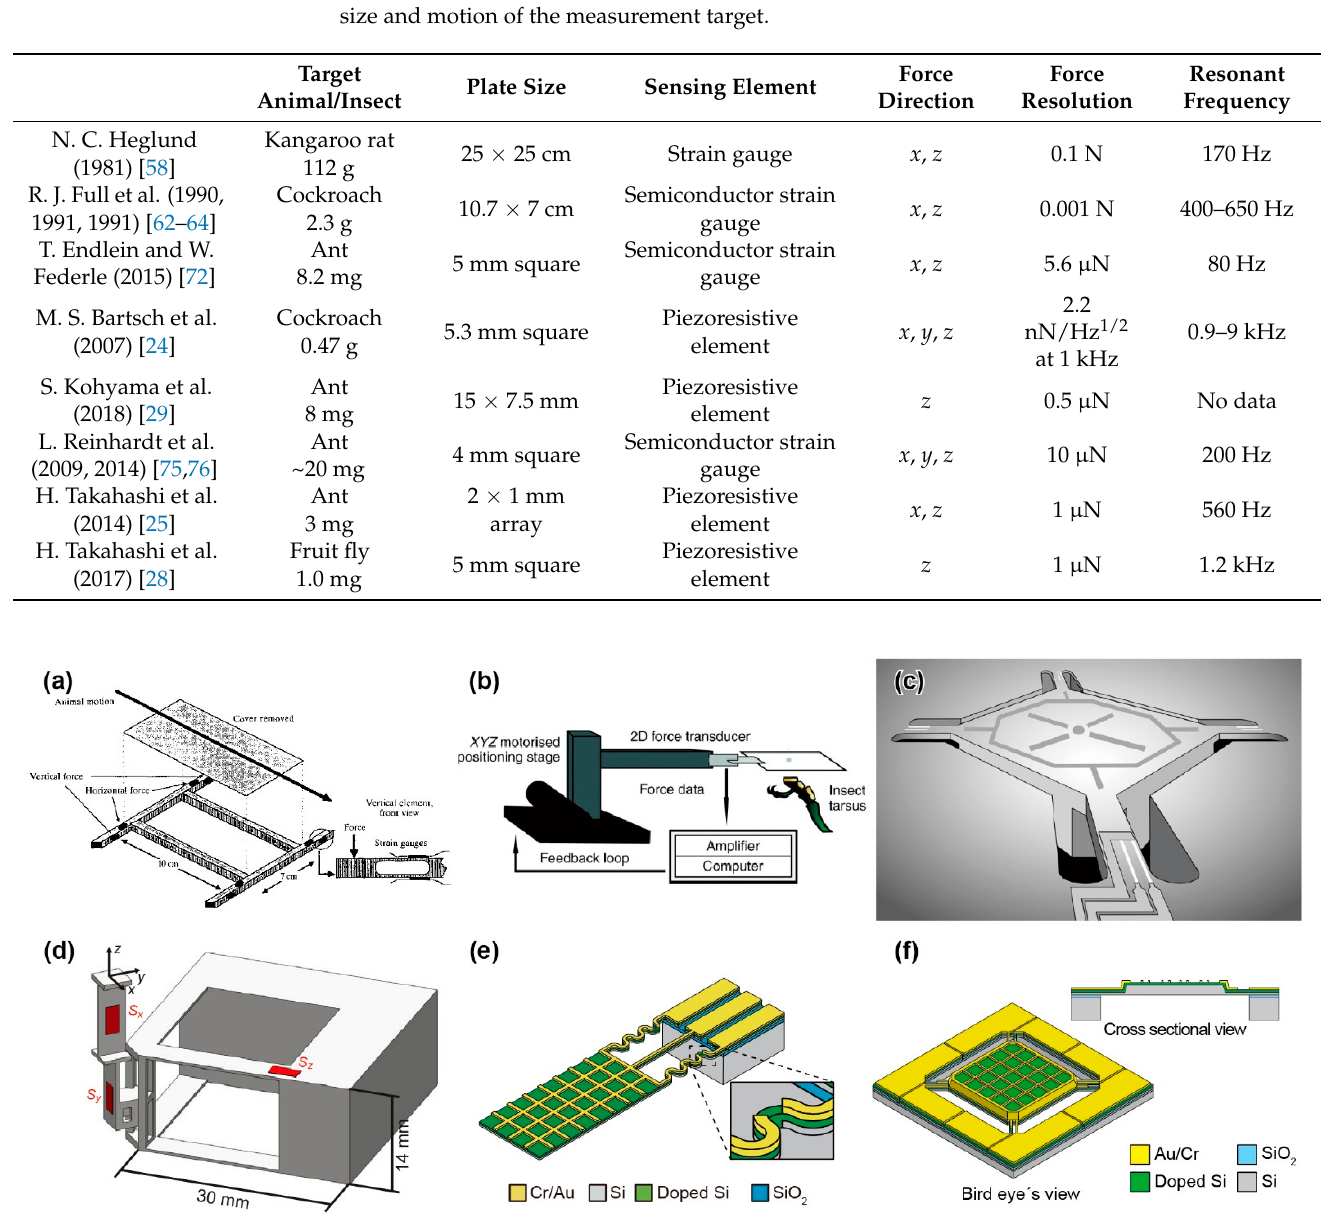
Figure 1. Schematic images of micro-force plates for insects. ( a ) Biaxial force plate for a cockroach. Reprinted/adapted with permission from Ref. [62]. 2022, Company of Biologists Ltd. ( b ) Biaxial force plate for measuring the GAF of soles. Reprinted/adapted with permission from Ref. [69]. 2022, Com- pany of Biologists Ltd. ( c ) Triaxial MEMS force plate for a cockroach. Reprinted/adapted with per- mission from Ref. [24]. 2022, IEEE. ( d ) Triaxial 3D-printed force plate for an ant.